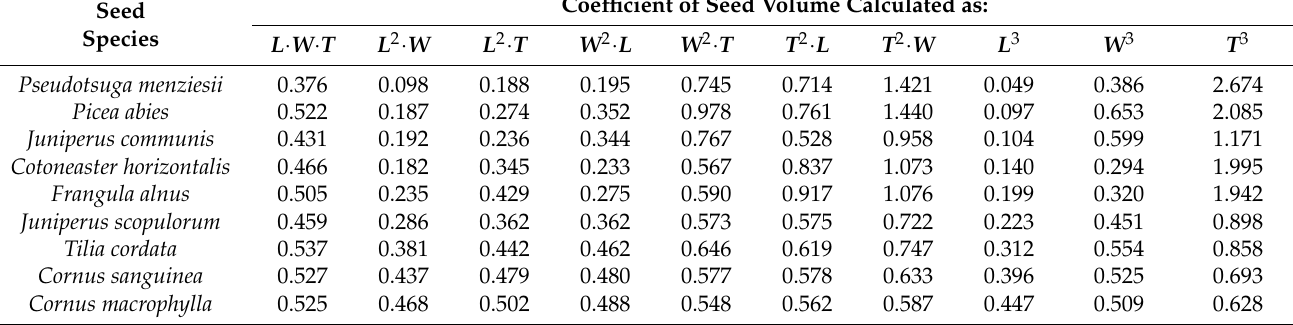
Table 3. Coefficients of seed